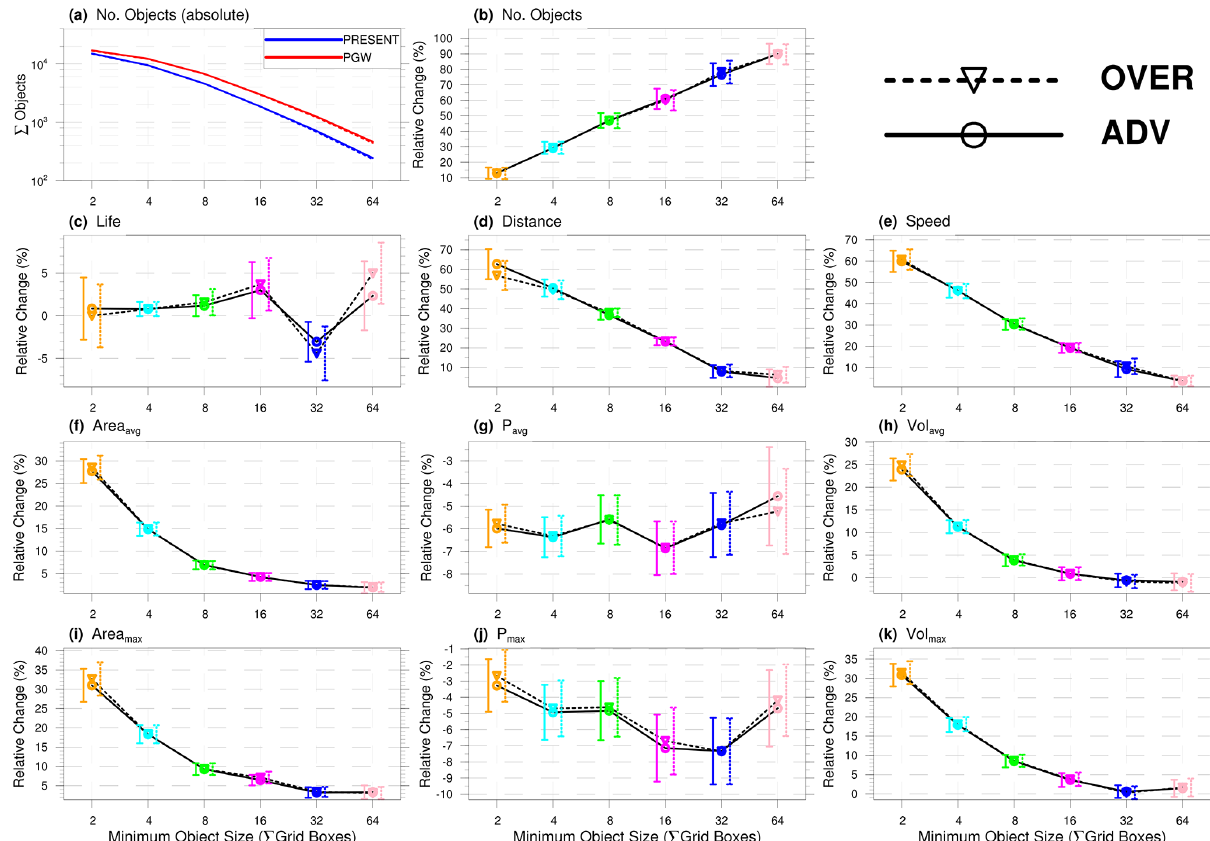
Figure 4. Climate-change signals of different object properties as a function of the object’s minimum-area ( A min ) criterion, for both al- gorithms. Change signals which are different with statistical significance at the 0.95 level can be identified based on non-overlapping CIs (Sect. 3.4), seen as vertical solid (advection) or dashed (overlap) lines. In panel (a) , the numbers of objects are shown (i.e. the sample sizes). A min is defined in terms of grid boxes, with each grid box having an area of ∼ 7 . 7km 2 . The A min range thus spans approximately 15 to 493km 2 . The values underlying the change signals can be seen in Fig.